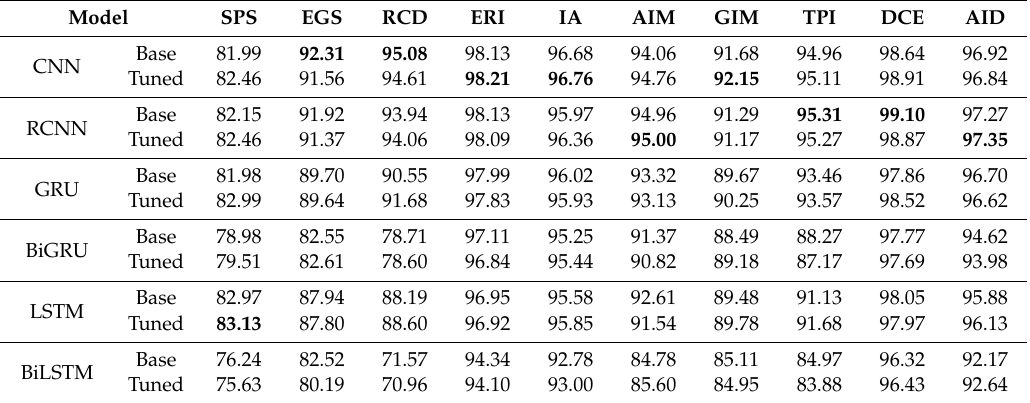
Table 6. Supervised algorithms on the labeled dataset (micro